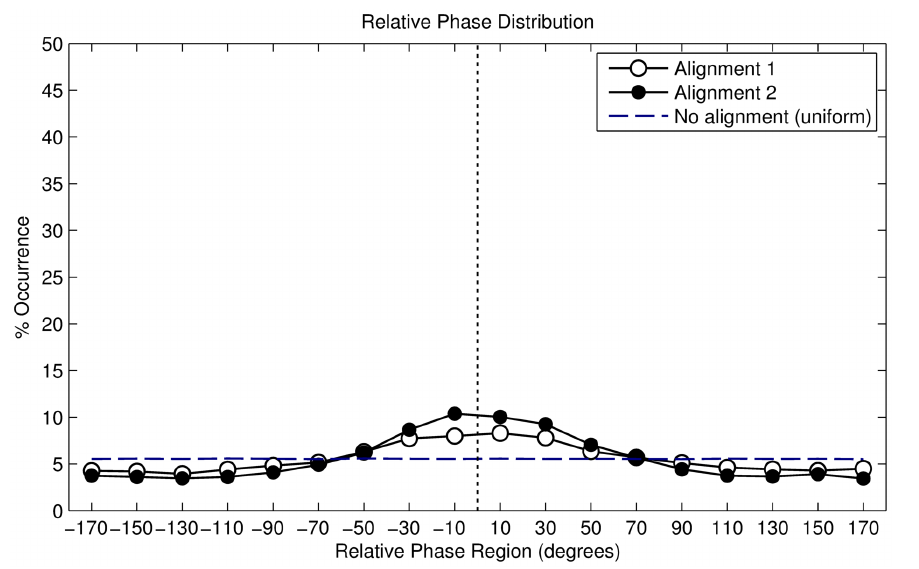
Fig. 8. Angular histogram of alignment strategy 2 (period-fixed